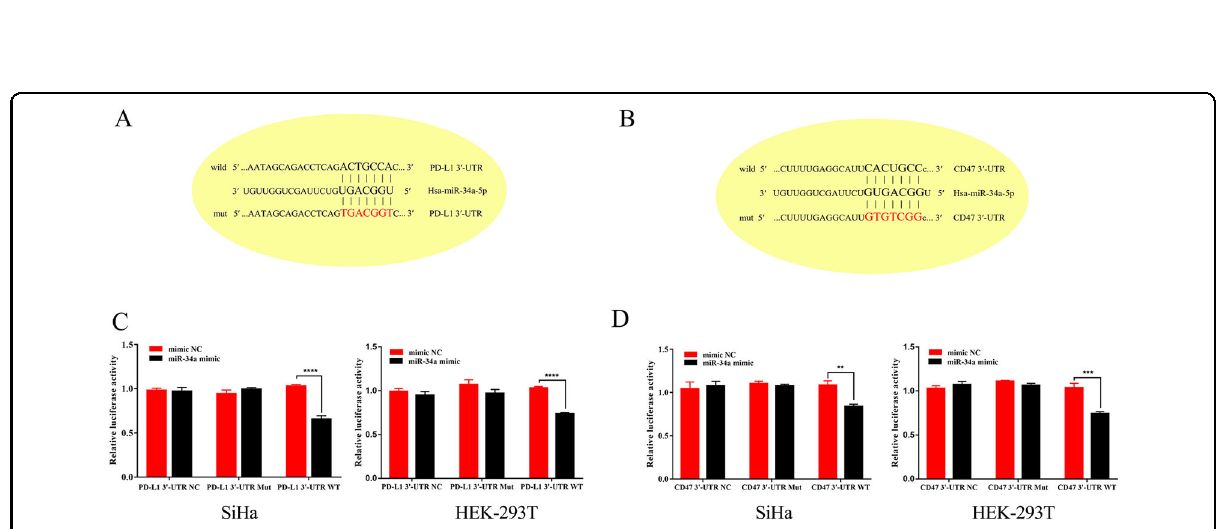
Fig. 4 miR-34a inhibits the translation of CD47/PD-L1 mRNA through targeting the 3 ′ UTR of the CD47/PD-L1. A , B The seed region of miR-34a has a highly complementary sequence to the 3 ′ UTR of CD47/PD-L1. C , D Luciferase reporter assays were performed in HEK-293T and SiHa cells with co-transfection of the negative control, wild-type, or mutant 3 ′ UTR constructs and mimic NC or miR-34a mimic ( n = 3 per group). Each experiment was repeated twice. N.S. not signi fi cant, ** p < 0.01; *** p < 0.001; **** p < 0.0001.